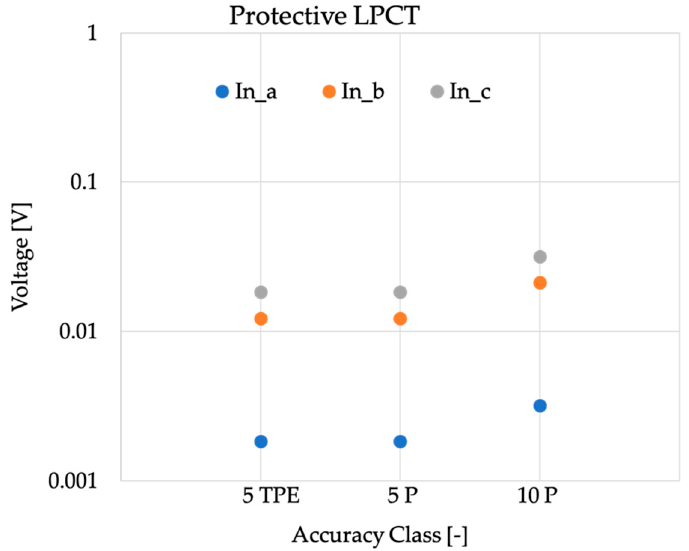
Figure 3. Absolute values of o computed from the rated outputs of Table 1 for protective purpose current transformers.